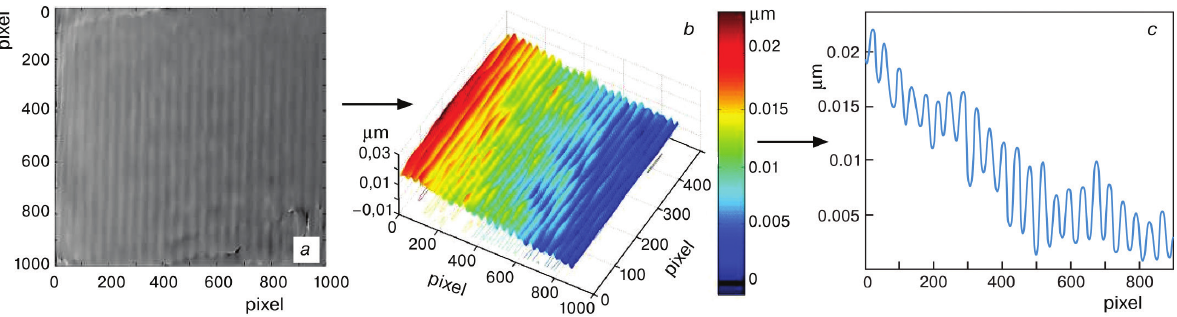
Figure 4. Visualization of SAW in specimen center under thermal deformations: ( a ) interference pattern, ( b ) restored motion field and ( c ) vertical section of motion field in wave vector plane ( a and b : 1.5× magnification (1000 × 1000 pixels along horizontal axes correspond to 6 × 6 mm 2 ); b and c : surface shift in vertical plane,